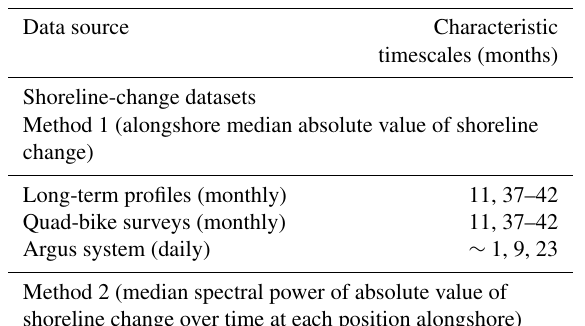
Table 1. Compilation of characteristic timescales in Figs. 2 and